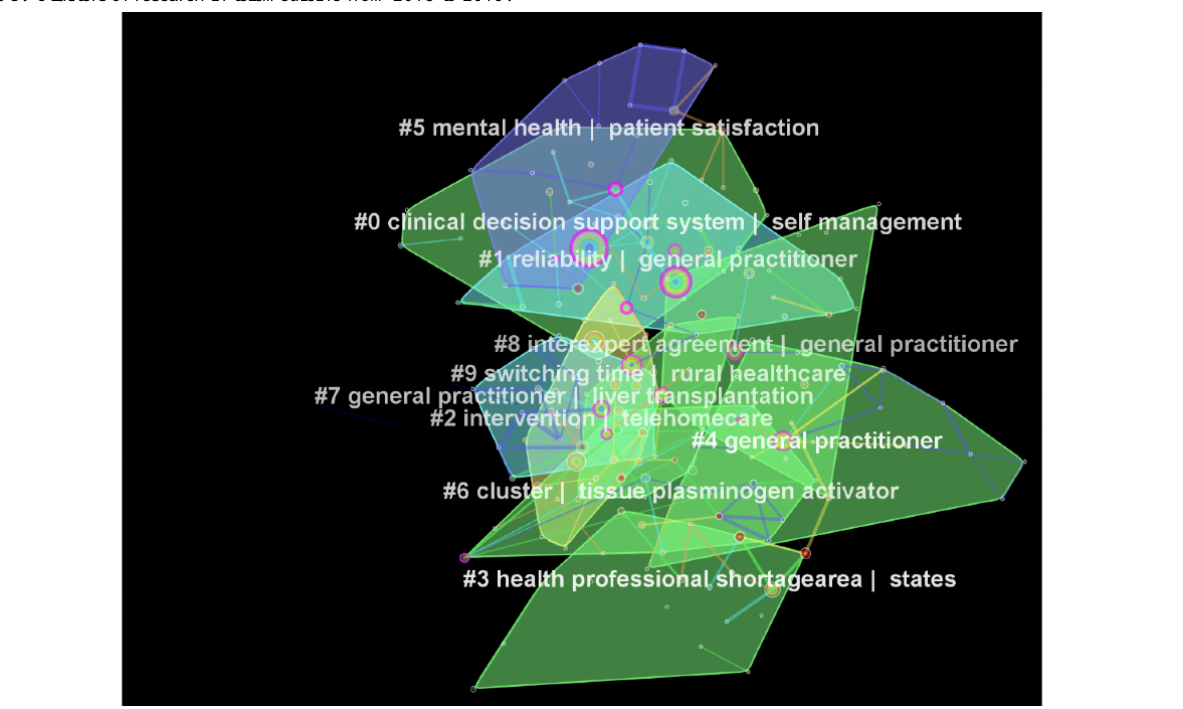
Figure 8. Clusters of research in telemedicine from 2015 to